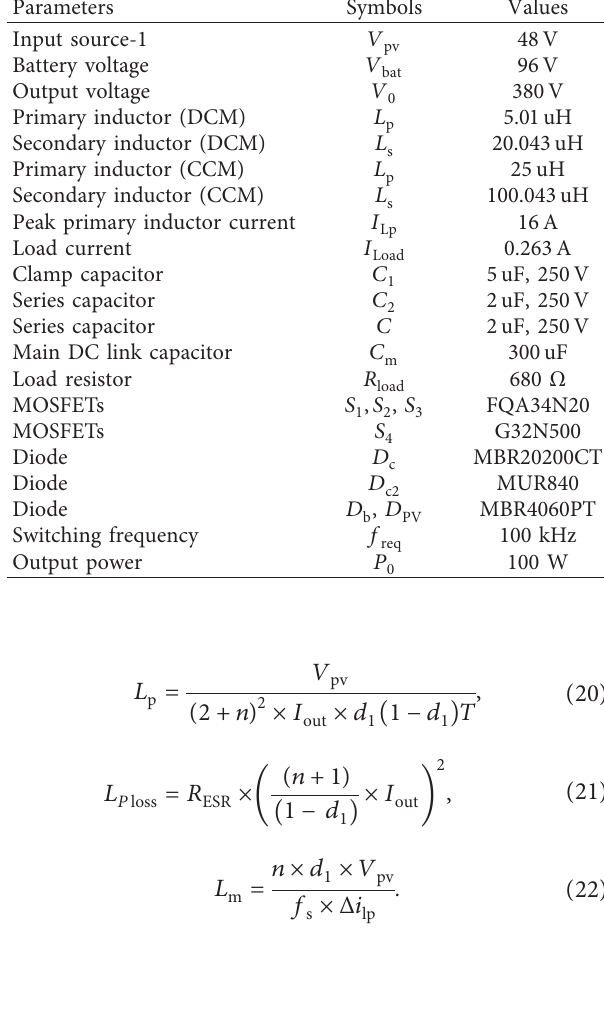
Table 1: Parameters’ symbols and values/components used for prototype and simulation.